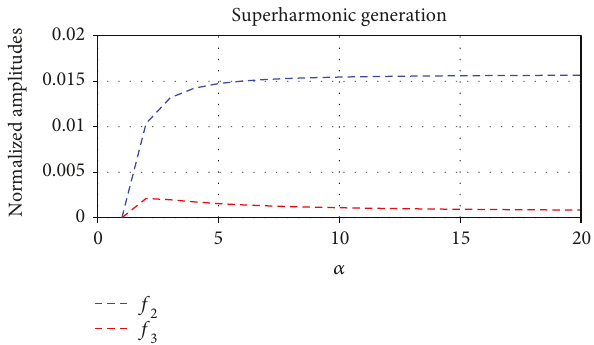
Figure 3: Normalized superharmonics with di ff erent amplitudes.